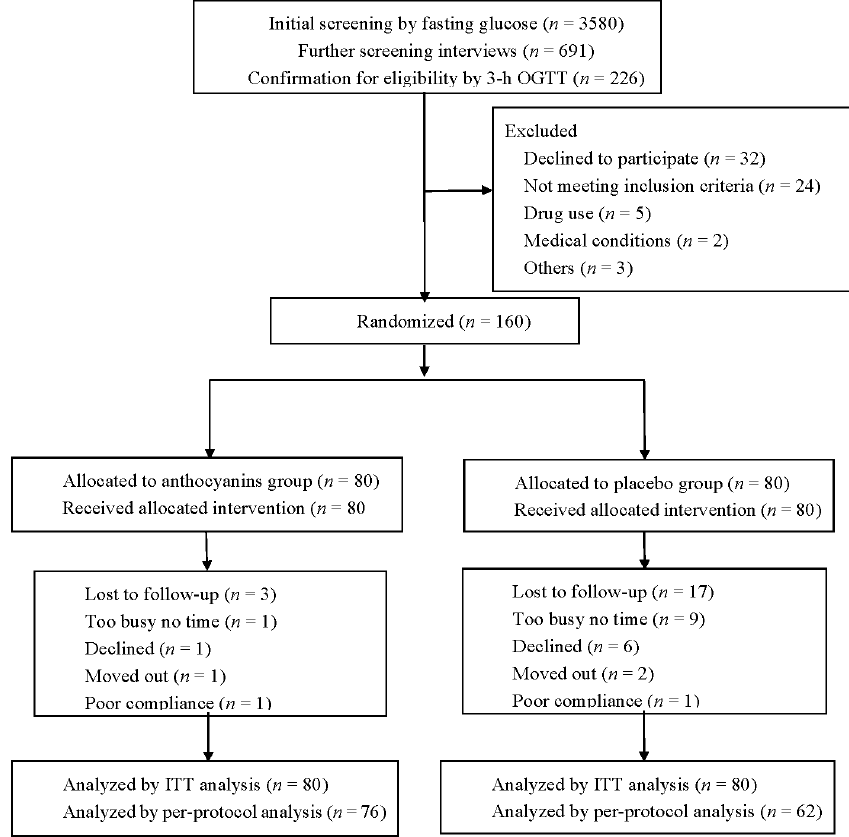
Figure 1. The CONSORT flowchart of the study. ITT = intention-to-treat. Table 1. Baseline characteristics of the 180 participants in anthocyanins and placebo groups.